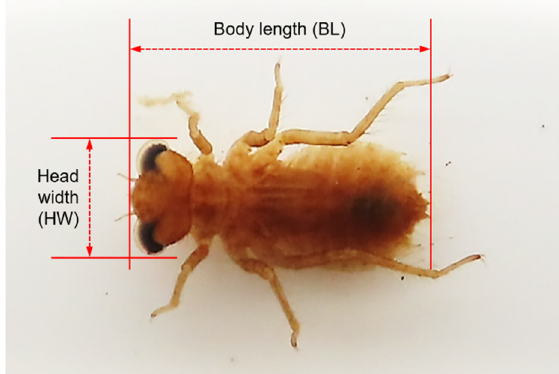
Figure 2. The body size measurement standards of Nannophya koreana ; head width (HW) and body length (BL).